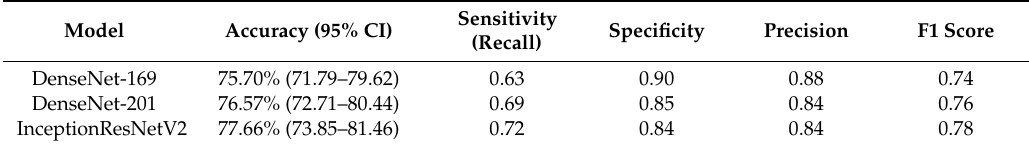
Table 3a. Model Performance Summary—Finger. Table 4. Model Performance Summary—Finger.